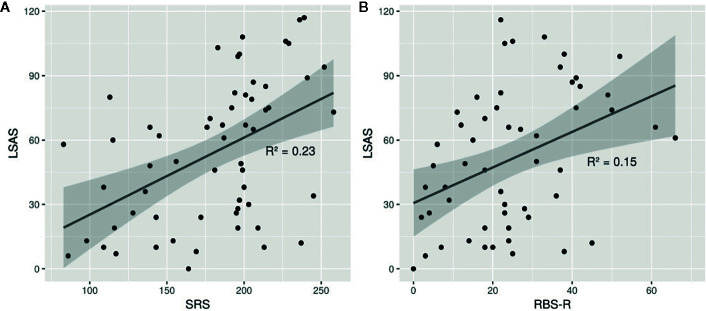
Point clouds representing the relationship between LSAS and SRS-2 total raw score/RBS-R total score. In (A), we could observe a positive relationship between the LSAS score and the SRS-2 score with a moderate correlation represented by a coefficient of determination R2 = 0.23. In (B), we could observe a weaker relationship between the LSAS score and the RBS-R score with a moderate correlation represented by a coefficient of determination R2 = 0.15. LSAS, Liebowitz Social Anxiety Scale; SRS-2, Social Responsibility Scale - 2; RBS-R, Repetitive Behavior Scale – Revised.